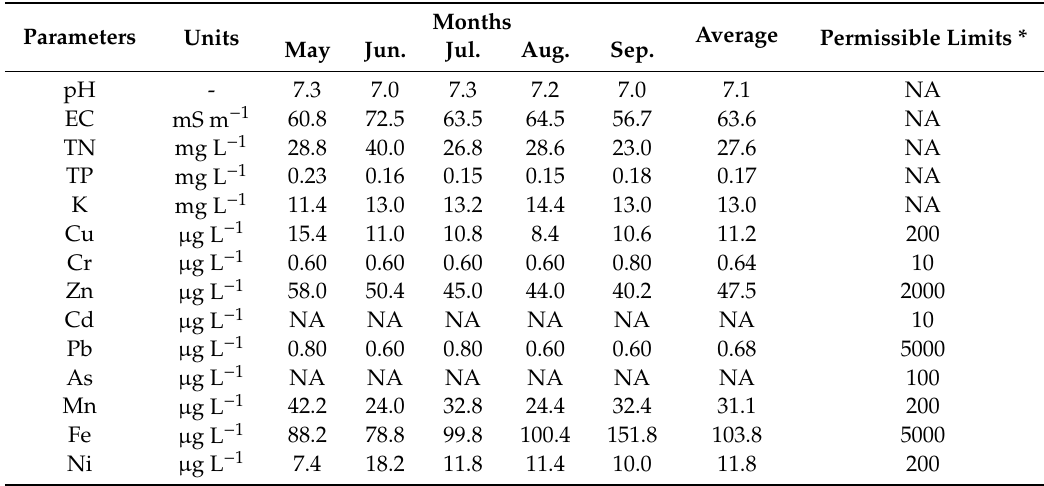
Table 2. Monthly average water quality of influent TWW.